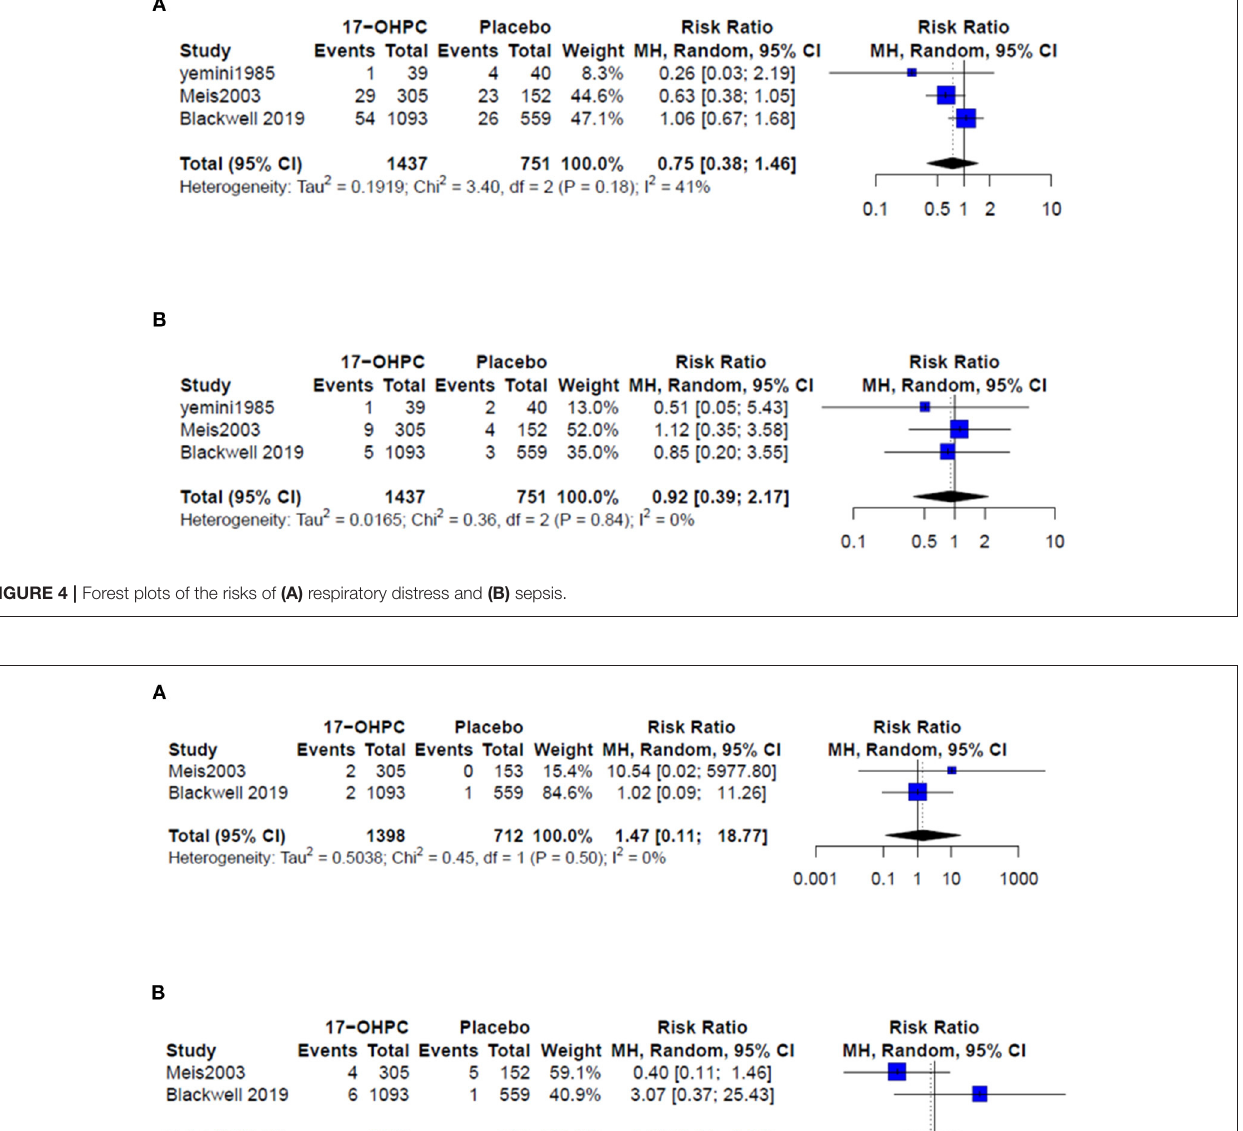
Frontiers in Medicine |